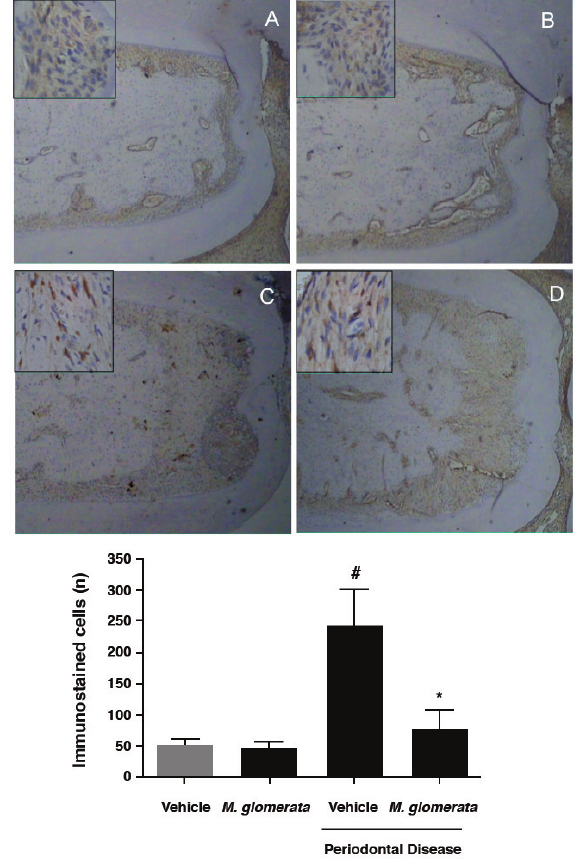
Figure 3- Immunohistochemical staining for RANKL. Expression patterns of RANKL in the periodontal tissue at the furcation of first molars sampled from the rats euthanized at 30 days are shown. Low number of positive staining cells for RANKL was observed in the furcation of non-ligated animals treated with vehicle (A) as well the non-ligated animals treated with Mikania laevigata extract (MLE) (B). Increased number of RANKL positive cells were found in the furcation of the ligated-animals treated with vehicle (C). Lower number of RANKL stained cells were found in the furcation of the ligated-animals treated with MLE (10 mg/kg/day for 30 consecutive days). (E) Data are presented as median ± standard deviation of the average RANKL positive cells/per area of furcation. Negative control staining was carried out by the incubation with secondary antibody alone that showed lack of immunostaining pattern in all experimental groups (data not shown). # p<0.05 compared with control animals; * p<0.05 compared with ligature-induced periodontitis treated with vehicle (ANOVA followed by Bonferroni’s test). The figure is representative of at least 4 different sections obtained from each group. Scale bar at lower (40x) magnification=100 μm, and scale bar at higher